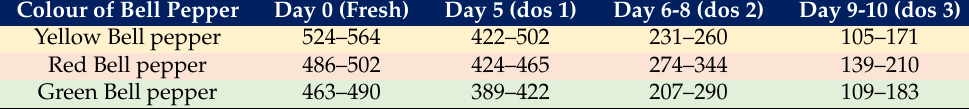
Table 2. Ranges of glossiness (luster) values for Bell pepper fruit of different colour (a.i.). Colour of Bell Pepper